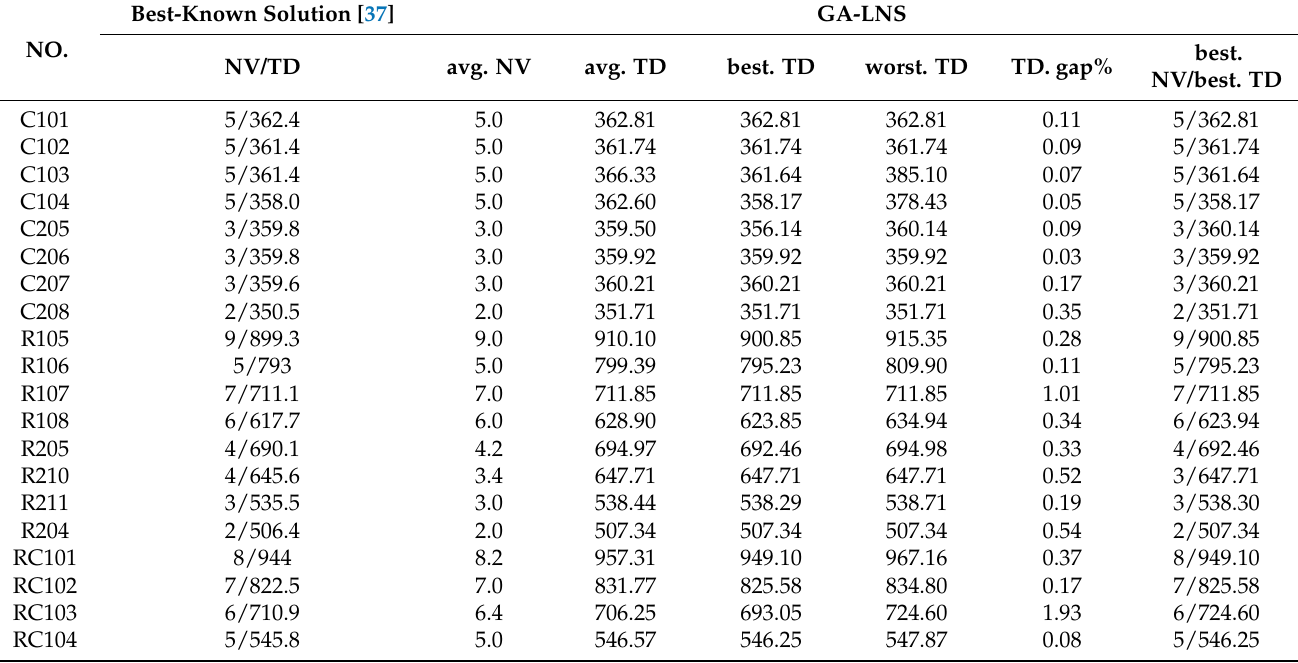
Table 4. The experimental results for the medium-scale of Solomon’s instances with VRPTW